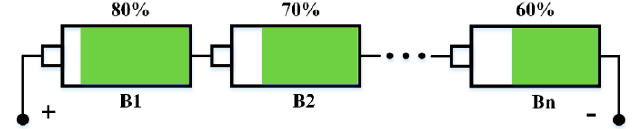
Figure 1. Different leveled SOC of individual batteries within a battery pack. Figure 1. Di ff erent leveled SOC of individual batteries within a battery